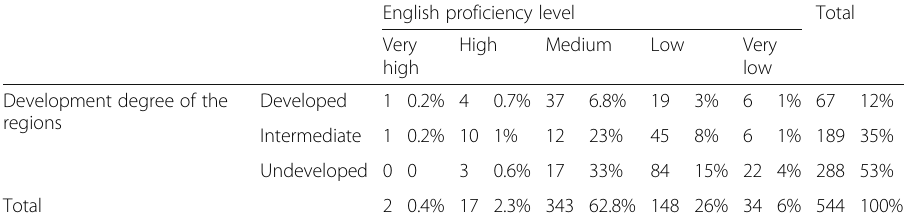
Table 2 Correlation between the development degree and English proficiency level English proficiency level